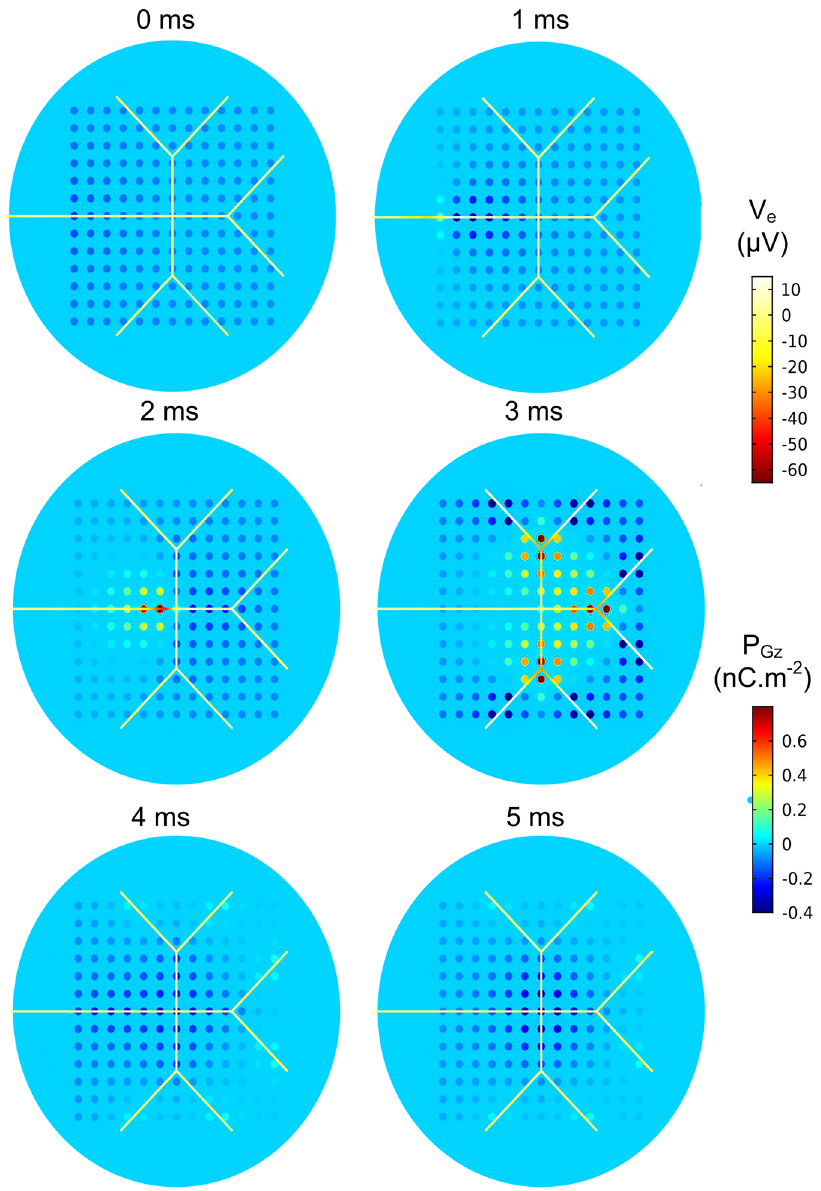
Figure 9. Simulated spatial performance of a 169 channel optrode device. Cross-sectional view of the optrode array at different time points relative to the endpoint of the electrical current pulse used to excite the leftmost segment of the neuron. The extracellular potential at the neuron, V e , is overlaid on the electric polarisation of the liquid crystal in the direction perpendicular to the plane of sensing, P Gz . The neuron diameter is not drawn to